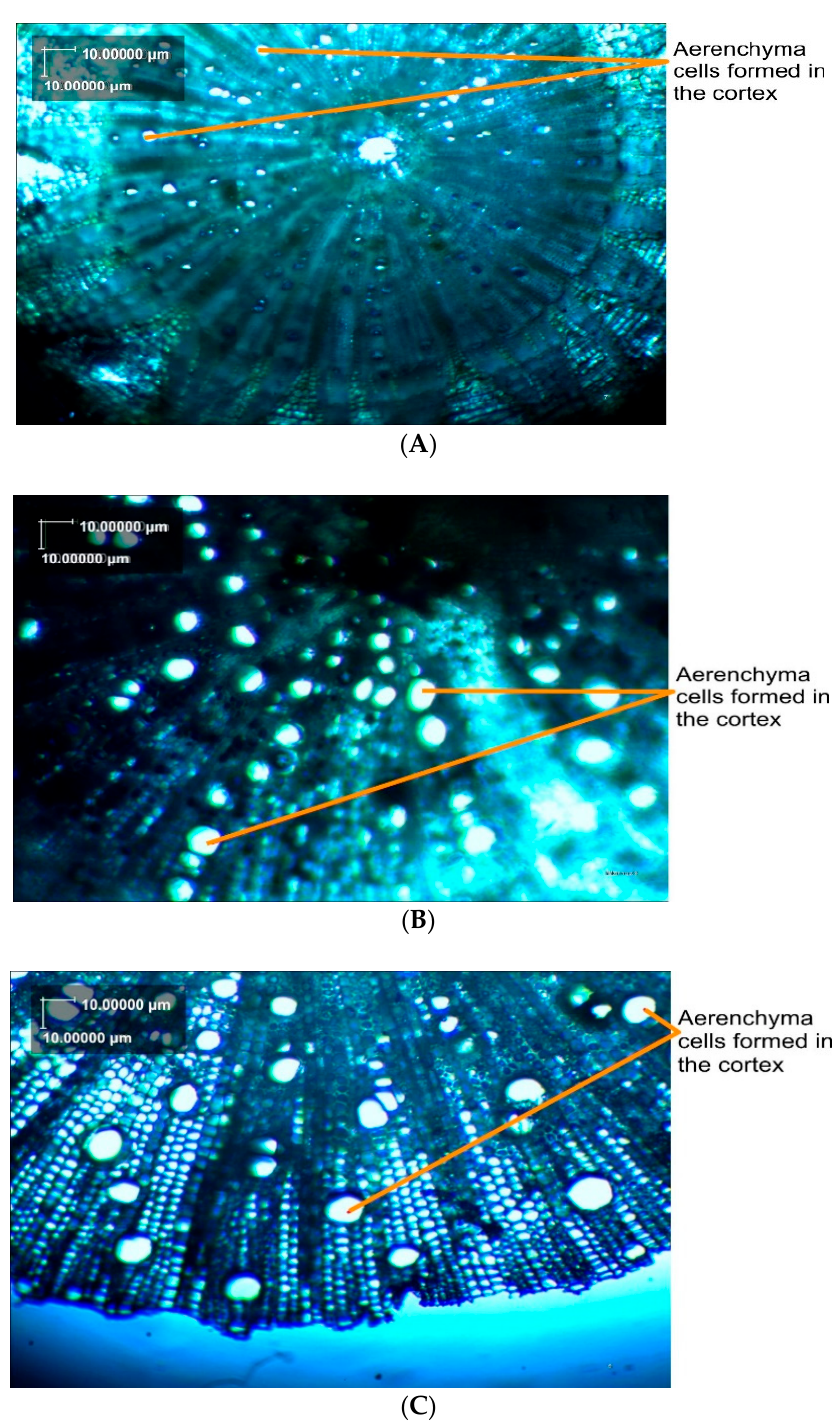
Figure 3. Root sections of okra plants grown from different concentrations of NaN 3 -treated seeds show aerenchyma cells formed under one-week waterlogging conditions. ( A ) 0% NaN 3 , ( B ) 0.02% NaN 3 , ( C ) 0.05% NaN 3 .